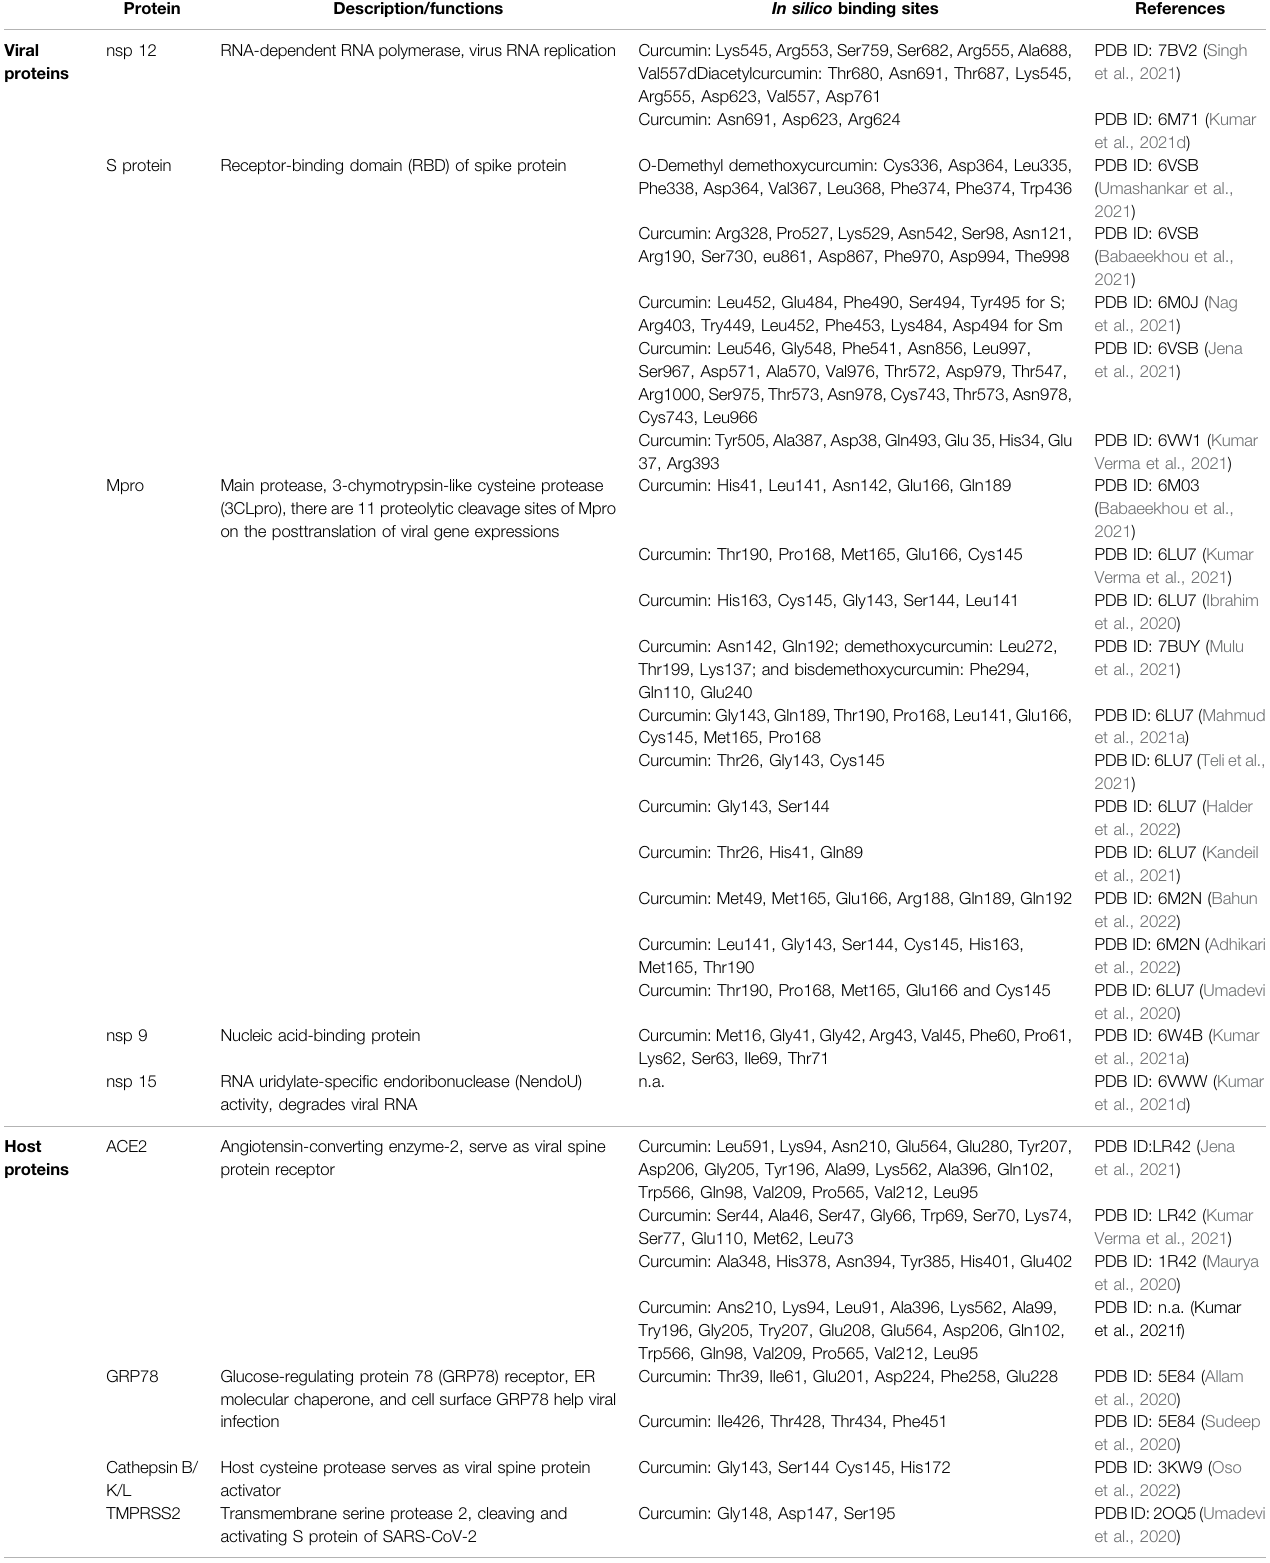
TABLE 1 | In silico studies of curcumin/curcuminoids on the viral proteins and host proteins with SARS-CoV-2 infection.